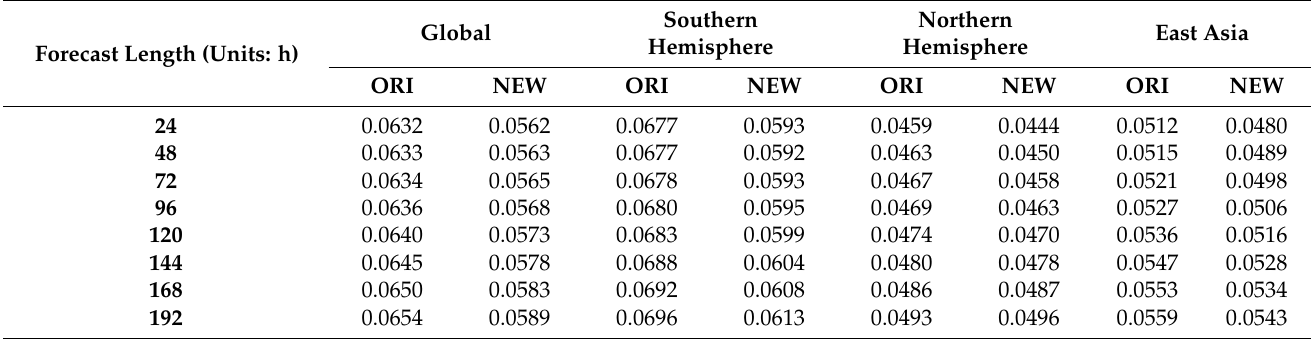
Table 9. RMSE of surface soil moisture between GRAPES forecast and GLDAS over different regions (units: m 3 ∙m -3 ).